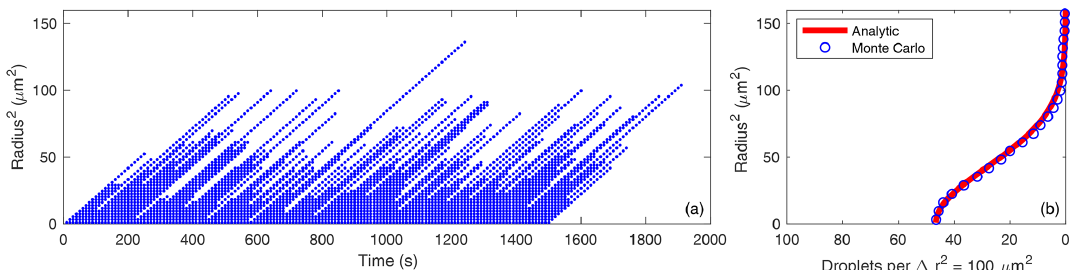
Figure 1. (a) Radius squared versus time for 150 droplets growing by condensation in 0.1% supersaturation, with probability of fallout per unit time of u/h = k 1 r 2 /h for h = 1m. (b) Frequency distributions of the radius squared from the Monte Carlo model (for 1 . 5 × 10 6 droplets) and from the analytic solution (Eq. 20) for the same parameters.